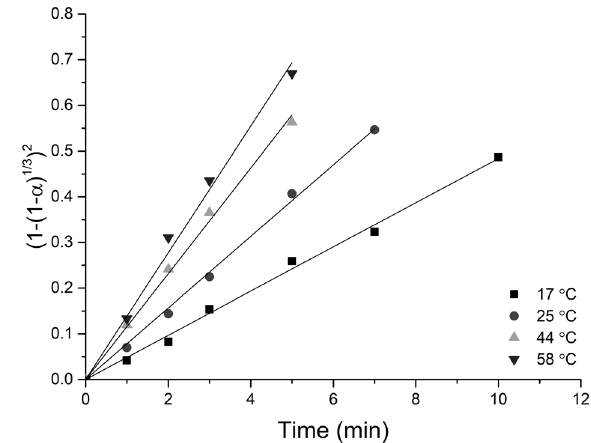
Figure 7: The dependence of [1-(1-α) 1/3 ] 2 vs. time of caffeine extraction.